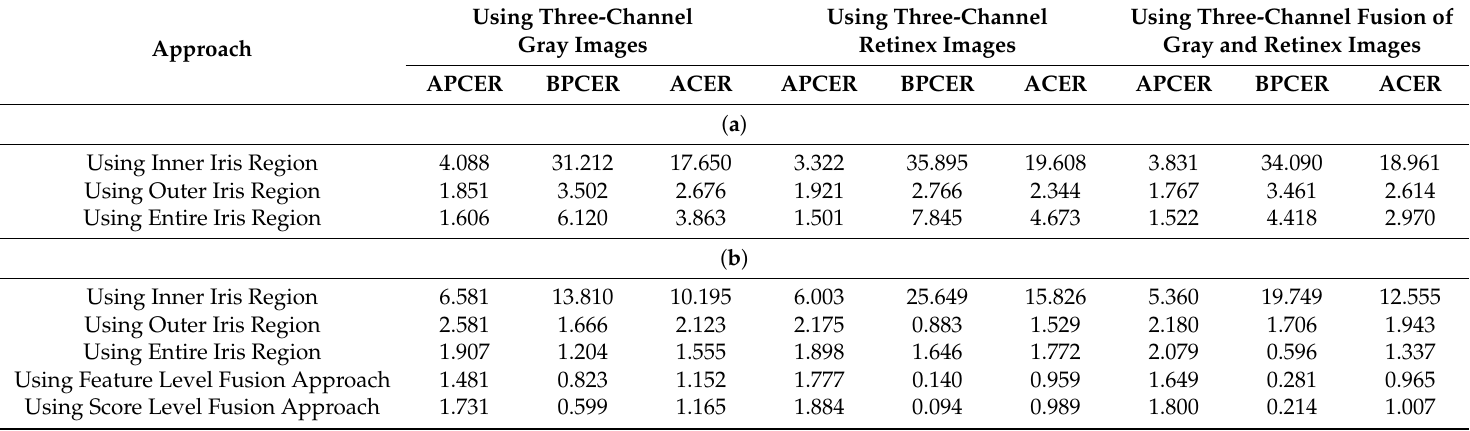
Table 10. (a) Detection errors (APCER, BPCER, and ACER) of iPAD based on CNN method for classification using NDCLD-2015 dataset with our second